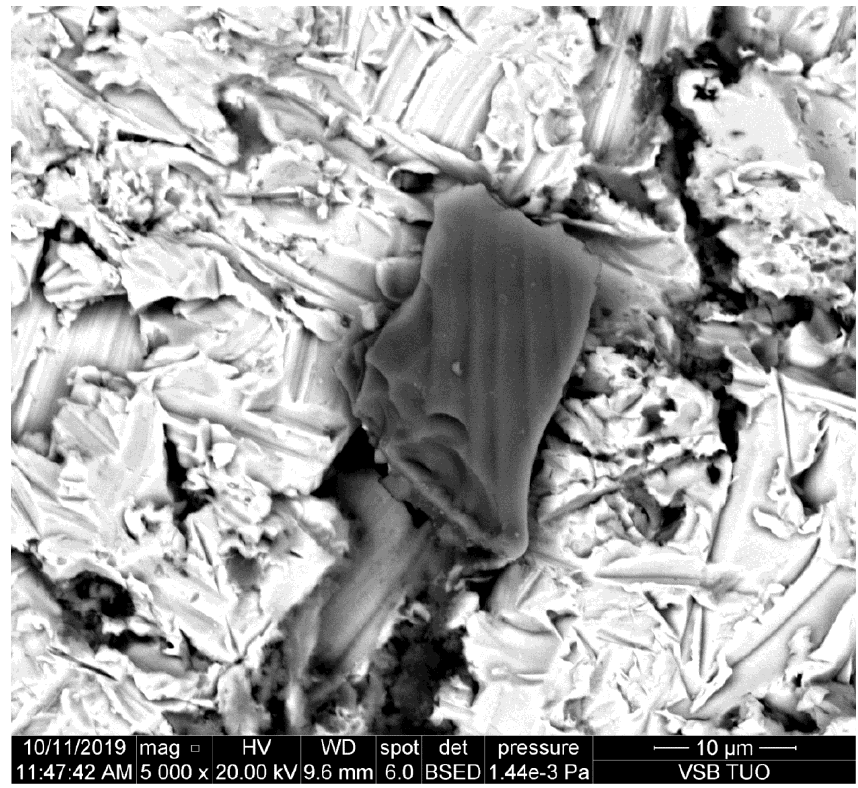
Figure 5. The abrasive particle detected in the cutting wall of the low alloy steel.